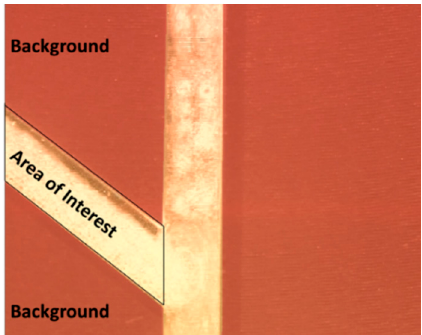
Figure 4. Example image of fluidised bed with 58 µm glass particles at 445 µL/min liquid flow rate inside 15% solid inventory bed. Area interest for the digital particle image velocimetry (PIV) analysis and a background are shown in the image.